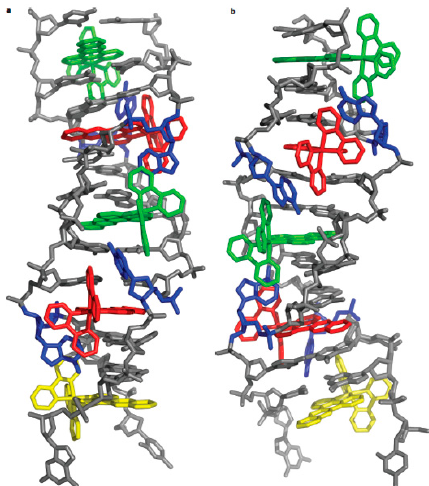
Figure 4. The structure of ∆ -[Ru(bpy) 2 dppz] 2+ bound to the oligonucleotide. ( a , b ) front view ( a ) and view rotated 90° around the helix axis ( b ). Three DNA-binding modes were observed, as follows: (1) metallo-insertion, whereby the ruthenium complex (red) inserts the dppz ligand into the DNA duplex (grey) at the mismatched sites through the minor groove, extruding the mispaired adenosines (blue); (2) metallo-intercalation, whereby the complex (green) binds between two well-matched base pairs; (3) end-capping, whereby the complex (yellow) stacked with the terminal Watson-Crick pair of the duplex. Reprinted with permission from the authors of [26]. Copyright © 2012, Springer